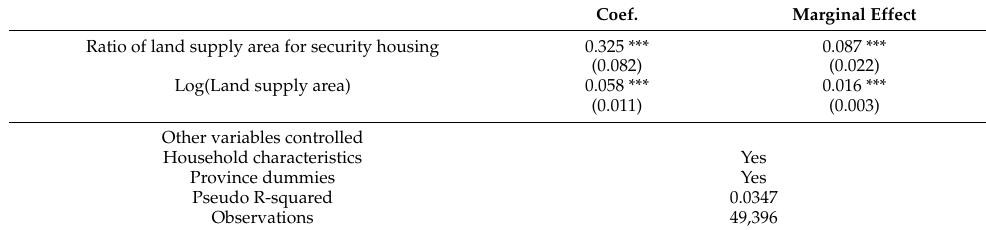
Table 4. Estimated results of housing security and settlement intentions (Probit regression).